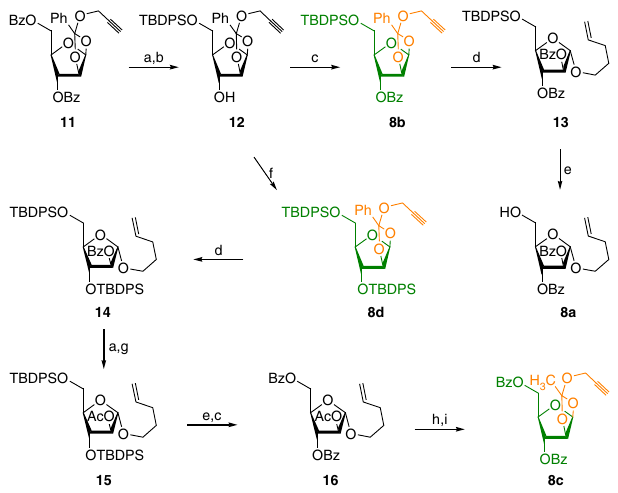
Figure 3 | Synthesis of arabinofuranoside-building blocks. Reagents and conditions: (a) NaOMe, MeOH, 25 (cid:2) C, 6h. (b) TBDPS-Cl (1eq.), imidazole, N , N 0 -dimethylformamide (DMF), 0 - 25 (cid:2) C, 12h. (c) BzCl, Et 3 N, CH 2 Cl 2 , 0 (cid:2) C - 25 (cid:2) C, 61%: three steps for 8b from 11 . (d) Pent-4-enol, AuCl 3 , 4Å MS, CH 2 Cl 2 , 25 (cid:2) C, 2h. (e) Py (cid:2) HF, THF:Py (5:1), 0 (cid:2) C - 25 (cid:2) C, 5h, 66%: two steps for 8a from 8b . (f) TBDPS-Cl (1eq.), Imidazole, DMF, 25 (cid:2) C, 10h, 74%: two steps for 8d from 11 . (g) Ac 2 O, pyridine, 0 (cid:2) C - 25 (cid:2) C. (h) Br 2 ,